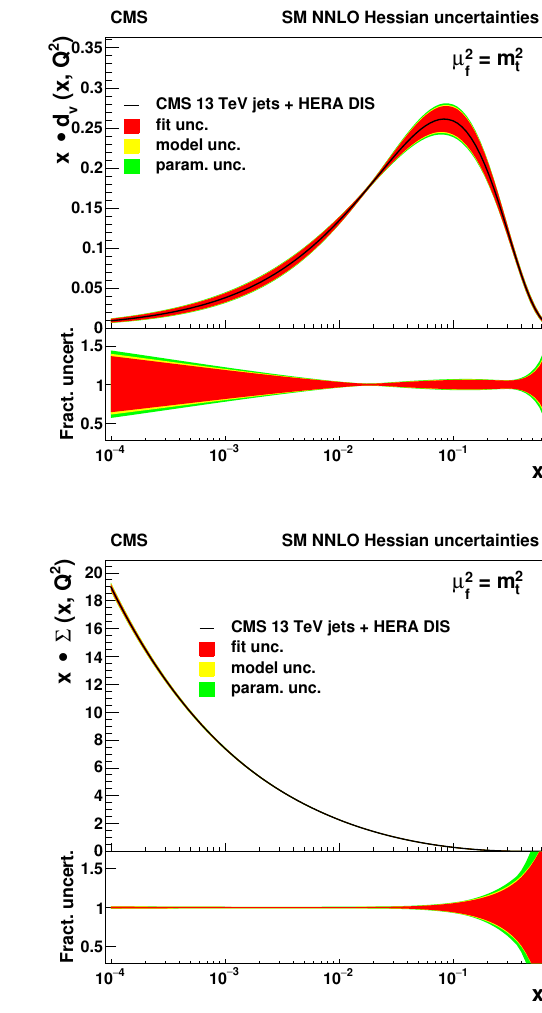
= m , resulting from the NNLO f t √ s = 13 TeV. The